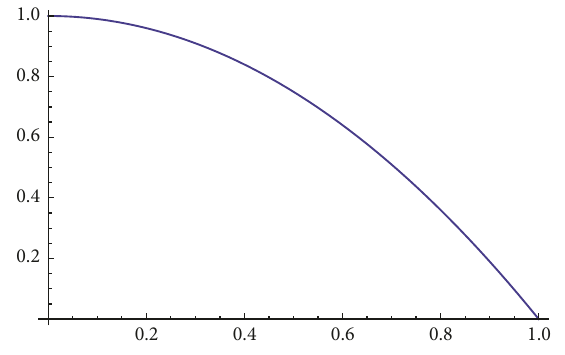
Figure 2: A plot of the string tension 𝜎(𝑇) against 𝑇/𝑇 𝑐 .